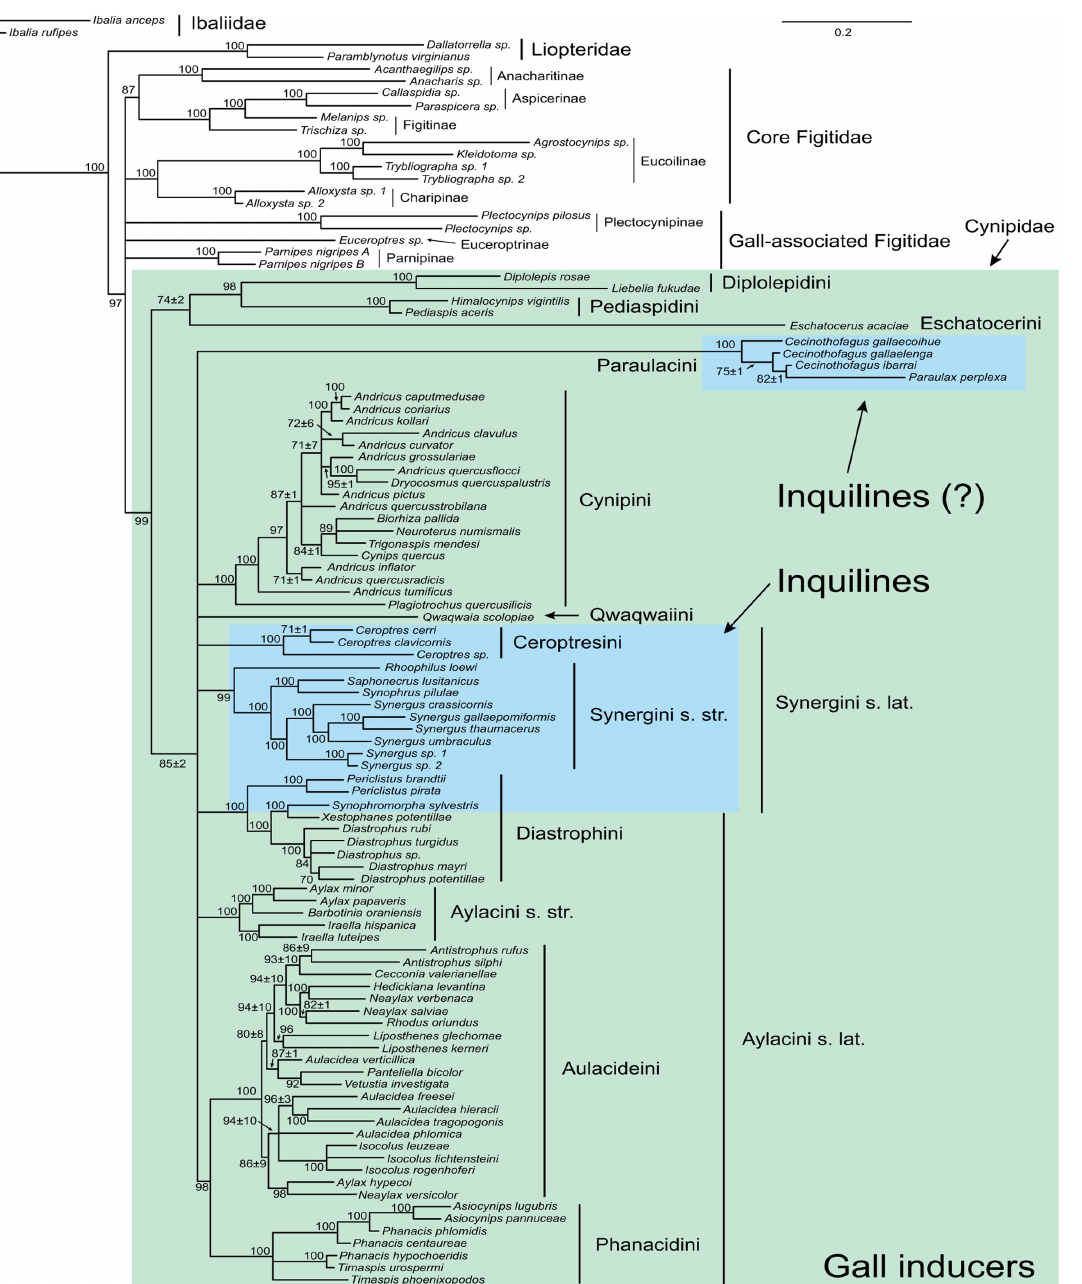
Fig 2. Results from analysis of the combined molecular, morphological and life-history data. Numbers on branches indicate estimated posterior clade probabilities (in % units) ± Monte Carlo error (error smaller than 1% not shown) across four separate analyses. Only groups with posterior probability above 70%